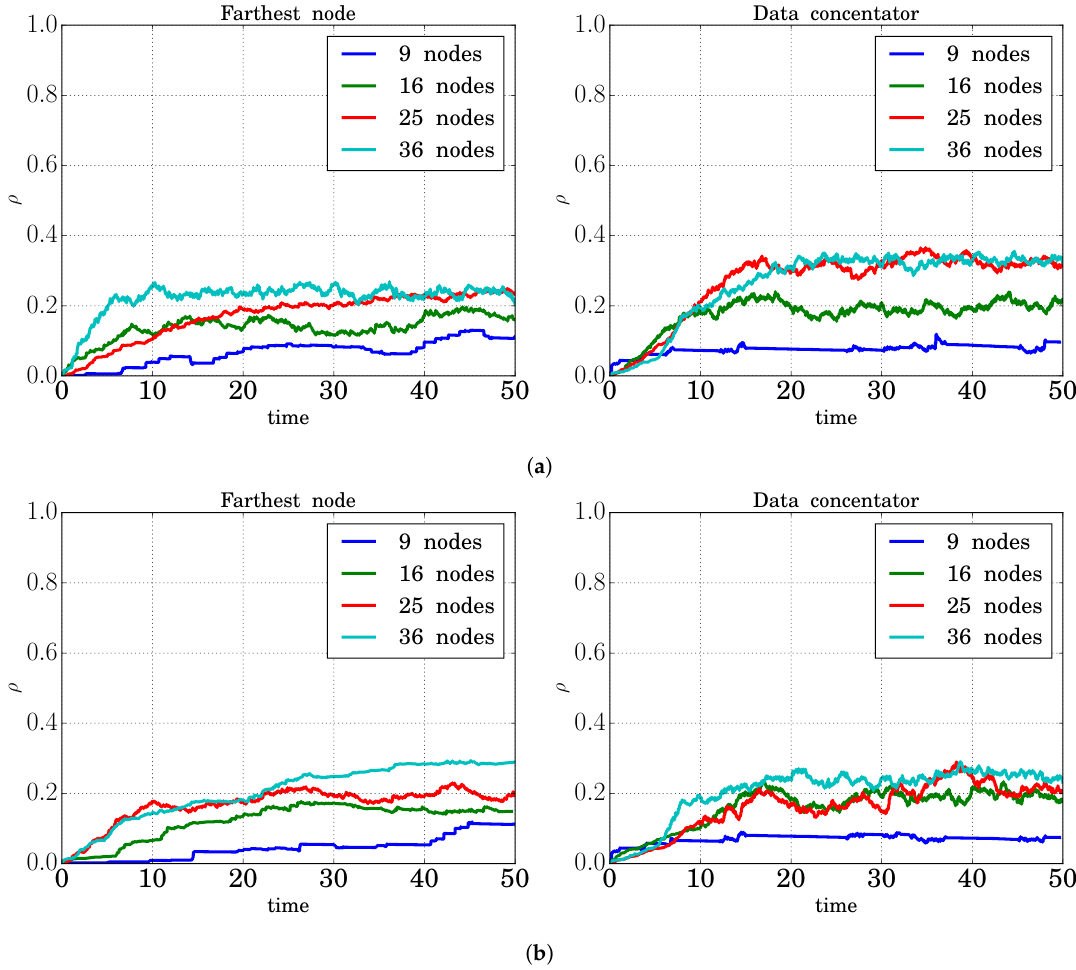
Figure 11. Control channel utilization factor. ( a ) Lifetime of reactive routing information: 2.05 s; ( b ) lifetime of reactive routing information: 5.12